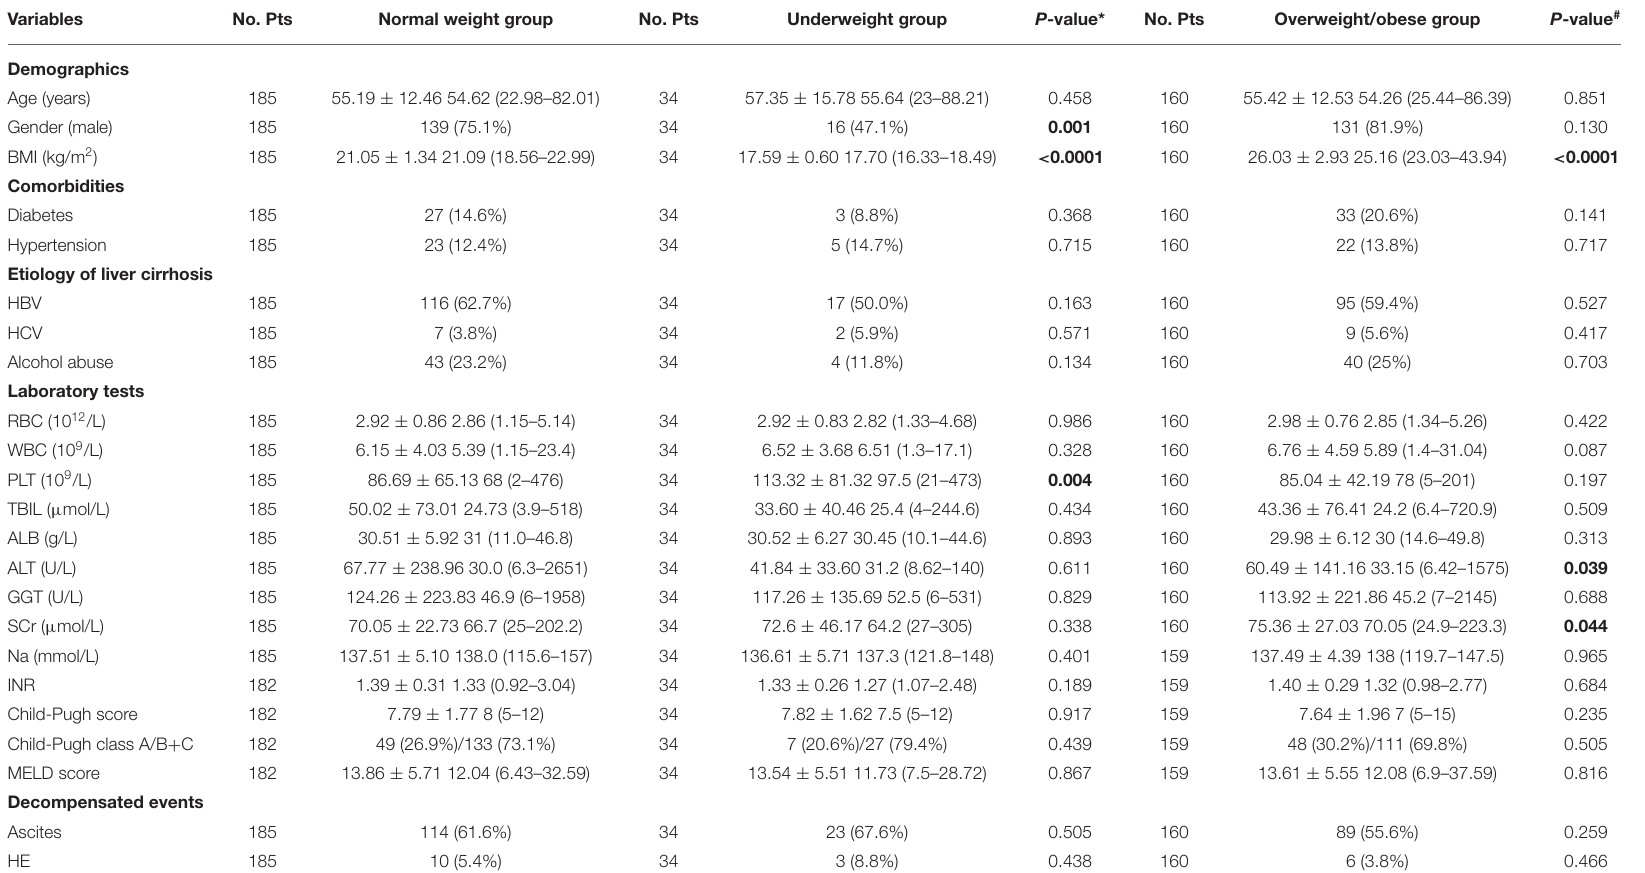
TABLE 2 | Baseline characteristics of patients with cirrhosis and with AGIB in the second